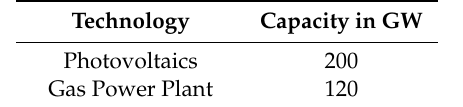
Table 1. Scenario parameters for the technologies in the simple